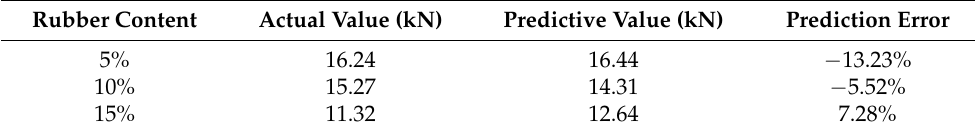
Table 11. Signal strength (8) single-parameter neural network prediction results.